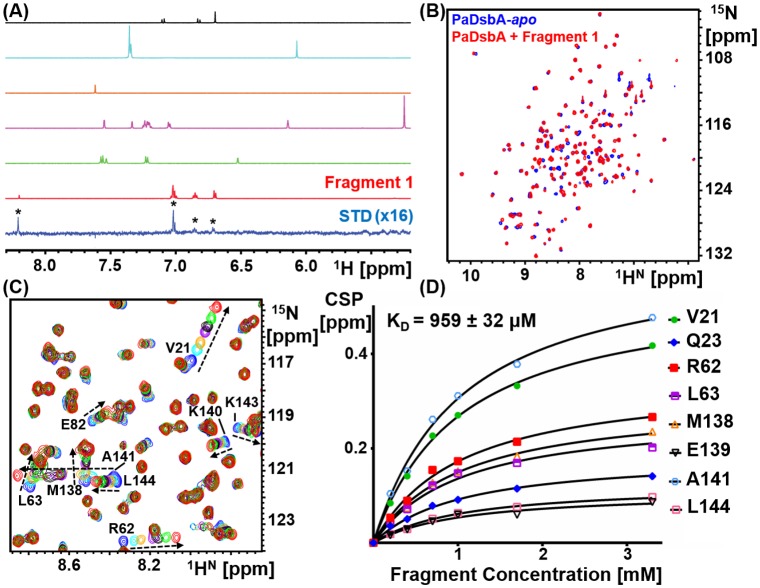
Screening and validation of the fragment library.(A) The fragment library was screened using ligand-detected 1H STD NMR. Pictured is an overlay of the aromatic 1H region of an STD spectrum (bottom spectrum, blue), plus the 1D reference spectra of fragments present in the cocktail (red, green, magenta, orange, cyan and black). In this instance, of the fragments present in the cocktail, only Fragment 1 whose spectrum is shown in red binds to PaDsbA1. STD fragment hits were validated by recording HSQC NMR using 15N labeled PaDsbA1. (B) Pictured is an overlay of the 15N-HSQC spectra of PaDsbA1 in the absence (blue) and presence (red) of Fragment 1, which reveals perturbation of a subset of residues. (C) The KD for each fragment was estimated from measurement of chemical shift perturbations in 15N-HSQC spectra of PaDsbA1 as a function of increasing fragment concentration. Shown is an overlay of one region of the 15N-HSQC spectra of PaDsbA1 in the absence (blue) and then increasing concentrations of Fragment 1 (0.2–3.3 mM). (D) The concentrations dependent chemical shift perturbation data were fitted to a one-site binding model to estimate a KD for the compound.